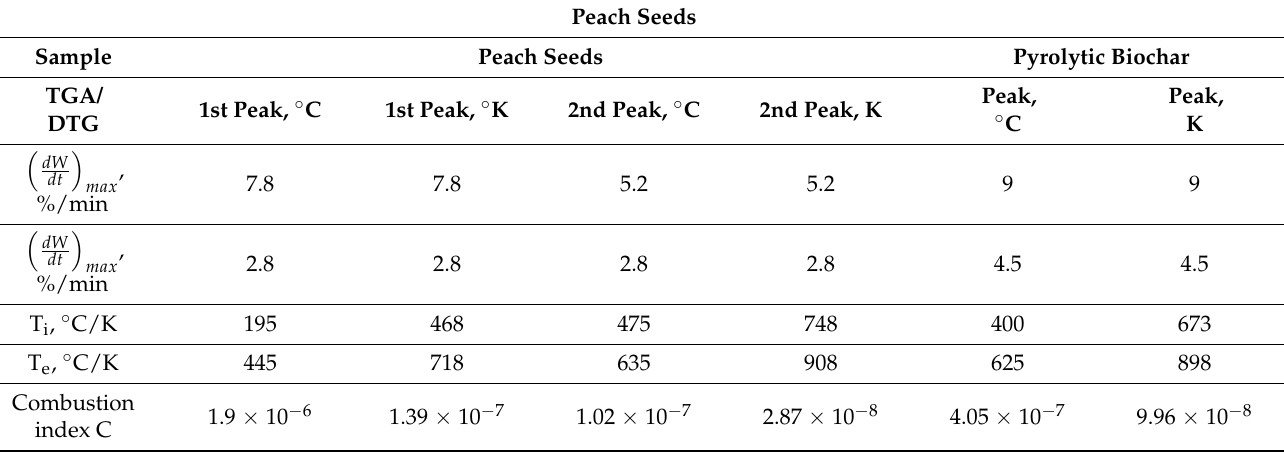
Table 8. Calculation of combustion index values. Peach